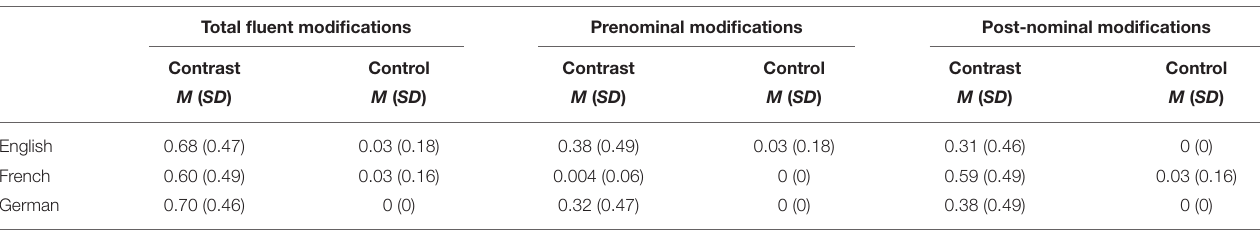
TABLE 1 | Proportions of utterances in which speakers modified the first noun phrase.